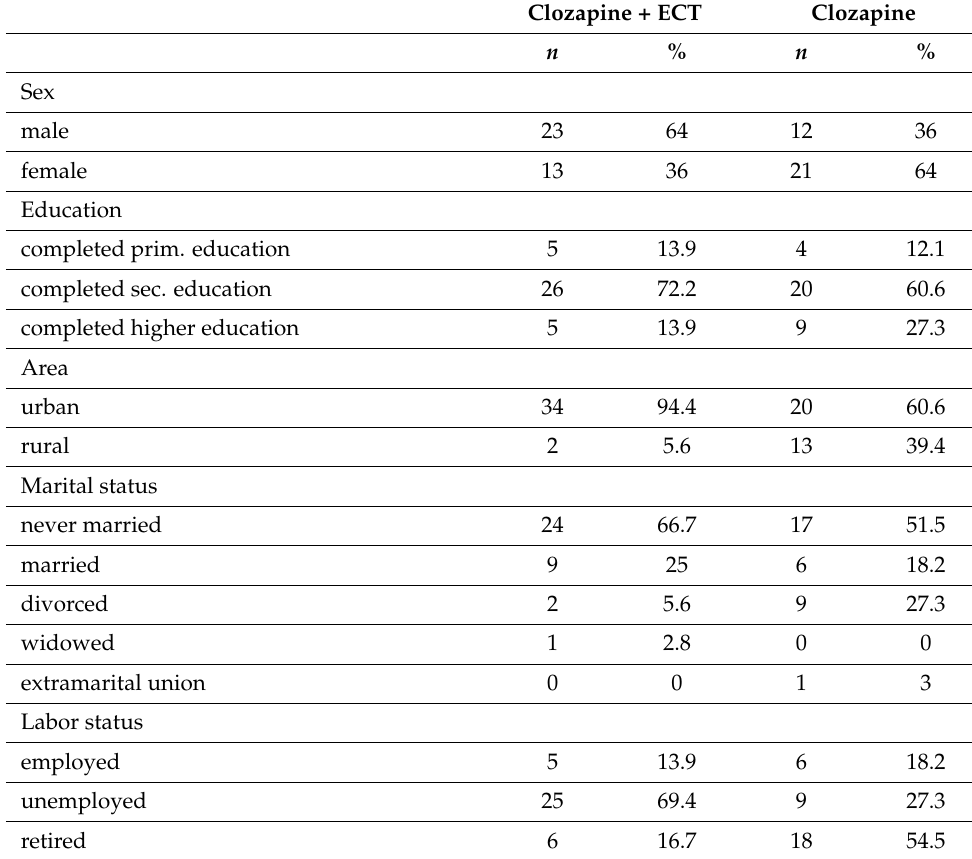
Table 1. Demographic and Clinical Characteristics of Patients by Treatment